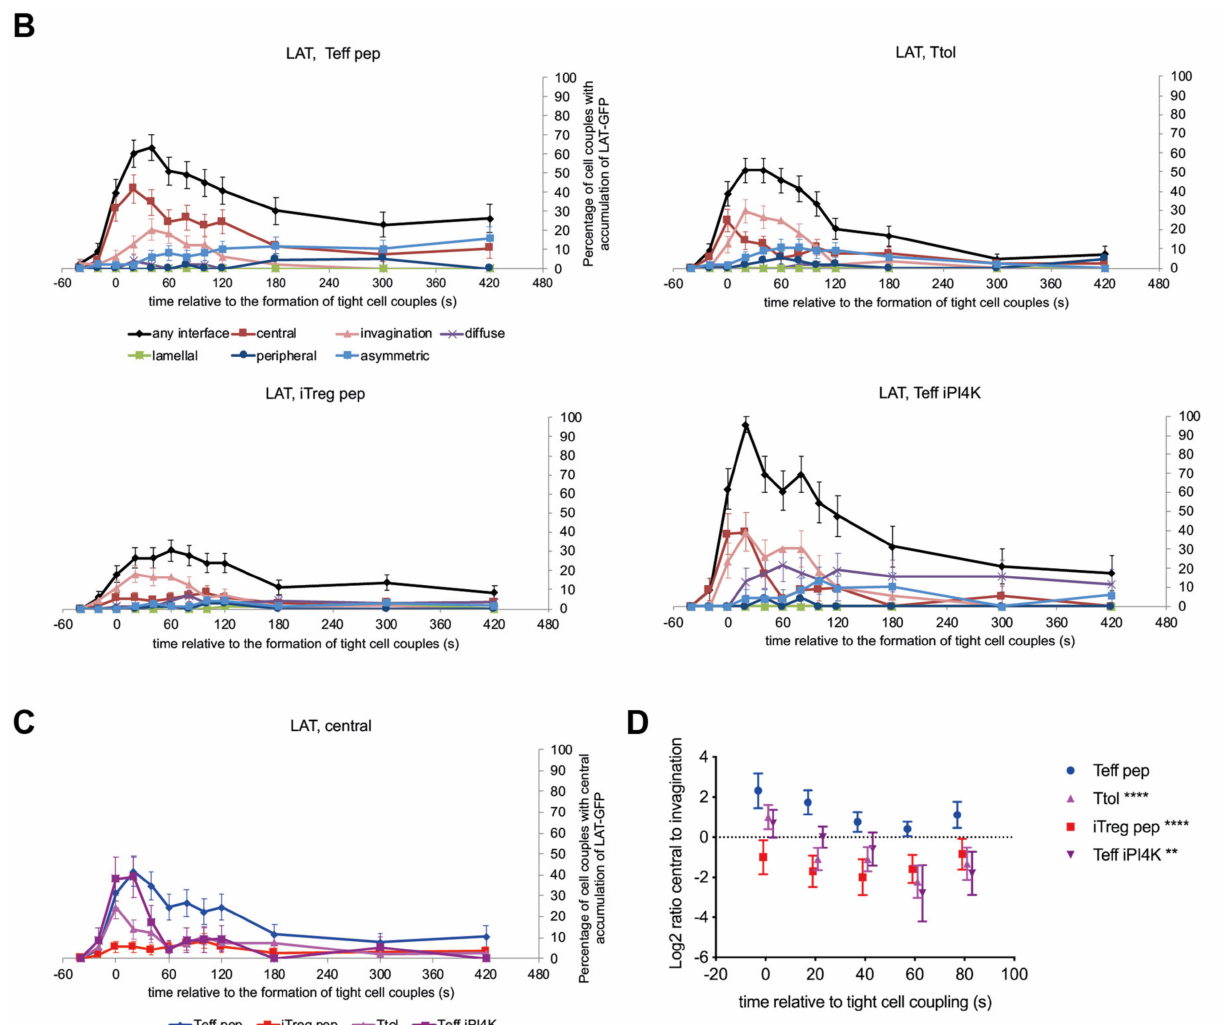
Figure 2. LAT association with the cSMAC is terminated more rapidly in T cells with regulatory capability. Tg4 T cells as indicated transduced to express LAT-GFP were activated with PL8 APCs (10 µ g/mL Ac1-9[4Y]). ( A ) Representative LAT-GFP imaging data. Differential interference contrast (DIC) images are shown in the top row, with top-down, maximum projections of 3-dimensional LAT-GFP fluorescence data in the bottom row. LAT-GFP fluorescence intensities are displayed in a rainbow-like false-color scale (increasing from blue to red). The scale bar corresponds to 5 µ m. Corresponding videos are available as Videos S1–S4. ( B , C ) Data are expressed as the percentage of cell couples with LAT-GFP accumulation in the indicated patterns (Supplementary Figure S2A) relative to tight cell couple formation. Number of cell couples analyzed are n = 49, 57, 72, 23 for Teff pep, Ttol, iTreg pep, Teff 9608 cells, respectively, from 2–5 independent experiments. Statistical significance of differences between conditions is given in Table S1; ( B ) all patterns for each cell type separately; C only central accumulation in direct comparison between the cell types; ( D ) The same data are expressed as the log 2 of the ratio of percent Tg4 T cells with accumulation in the central over the invagination pattern relative to tight cell couple formation. Values above 0 indicate preferential central accumulation, below 0 preferential accumulation in the invagination. Data points are slightly nudged to increase legibility. ** p < 0.01, **** p < 0.0001 vs. Teff